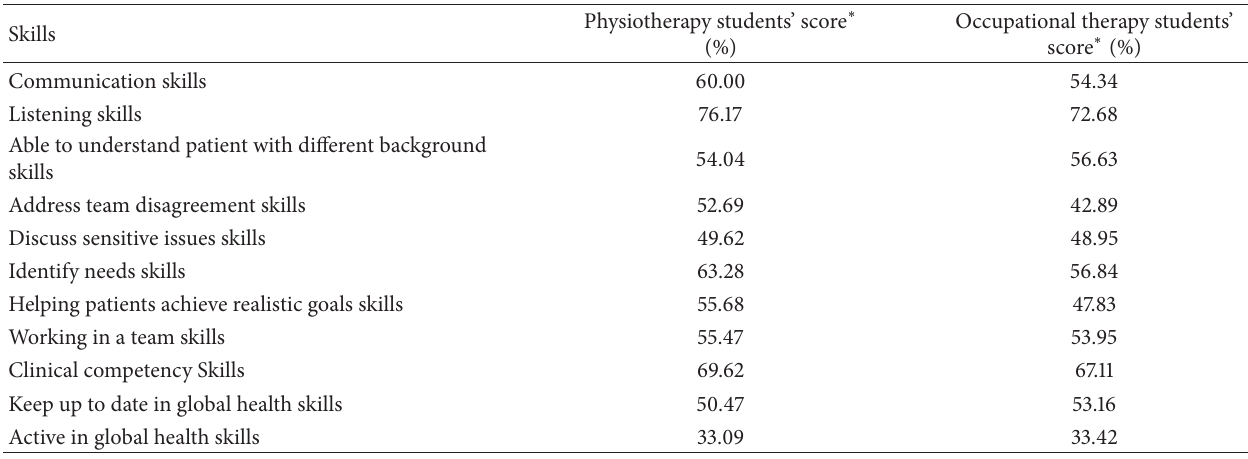
Table 3: Perceived global health skills for physiotherapy and occupational therapy students guided by the CanMEDS